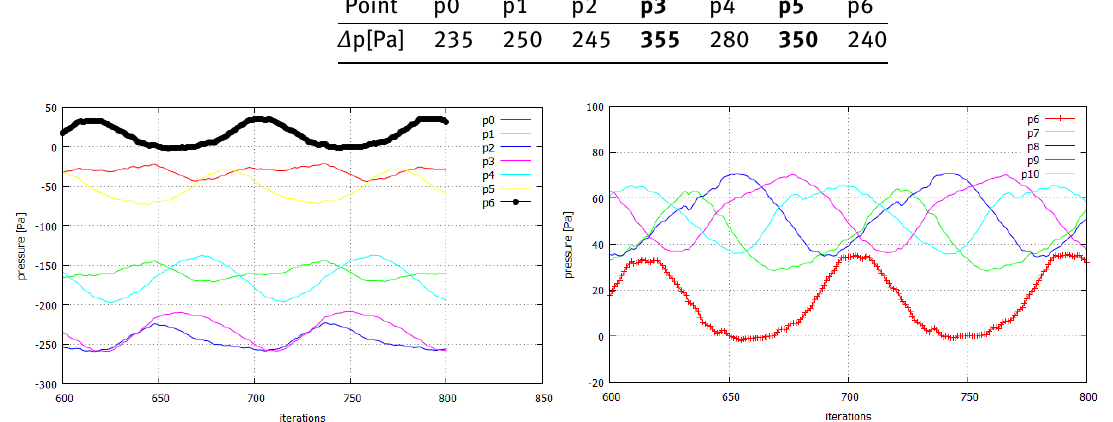
Figure 9: Pressure evolution for case B2 along the diaphragm at points p0,...p6 (left) and p6,...p10 (right).